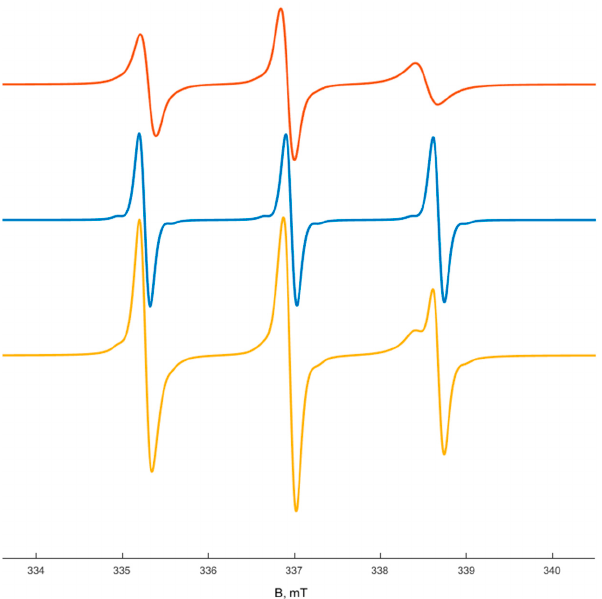
Figure 5. Deconvolution for the EPR spectra of TEMPO in the polymer IV solution (10 wt%): TEMPO in globules (red line), TEMPO in external solution (blue line), experimental spectrum of TEMPO in globules and external solution (yellow line).